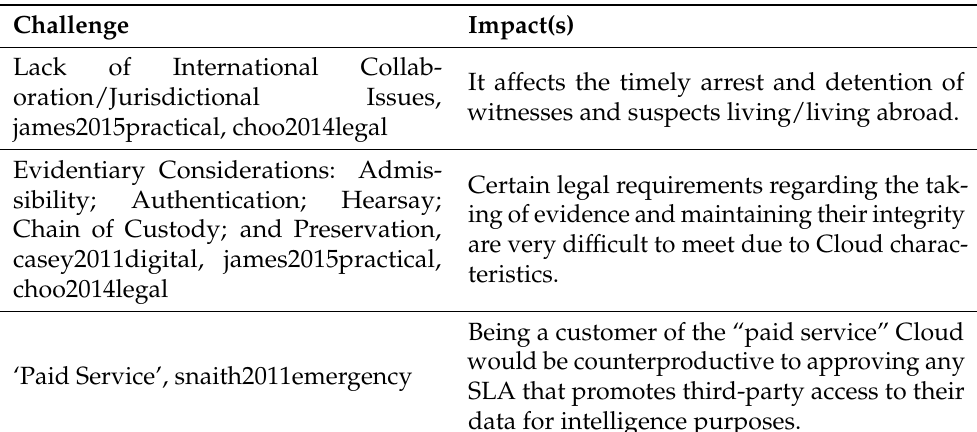
Table 6. Cloud forensic: legal